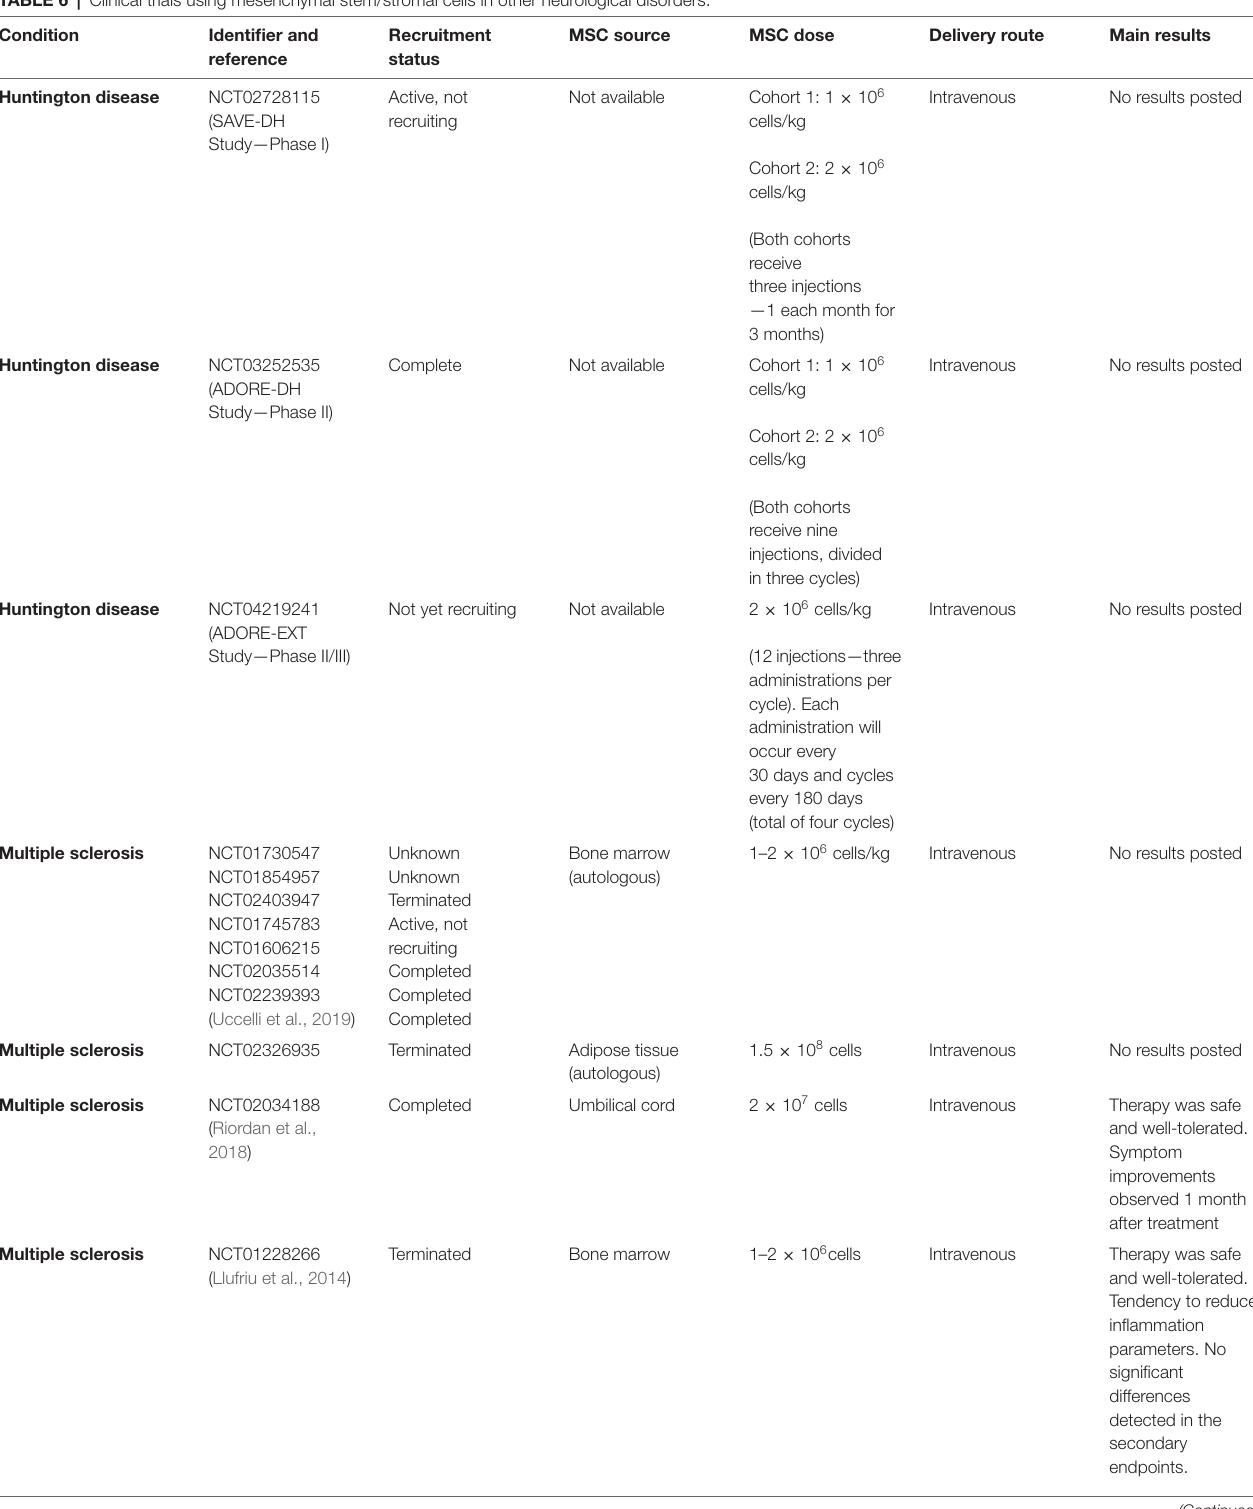
TABLE 6 | Clinical trials using mesenchymal stem/stromal cells in other neurological